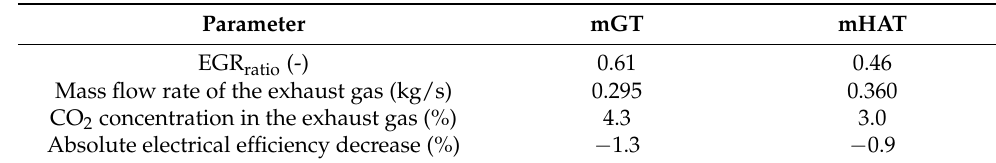
Table 5. Comparison of mHAT and mGT at 100 kW electrical load, 16% O 2 in the combustor inlet, and constant turbine outlet temperature (adapted from